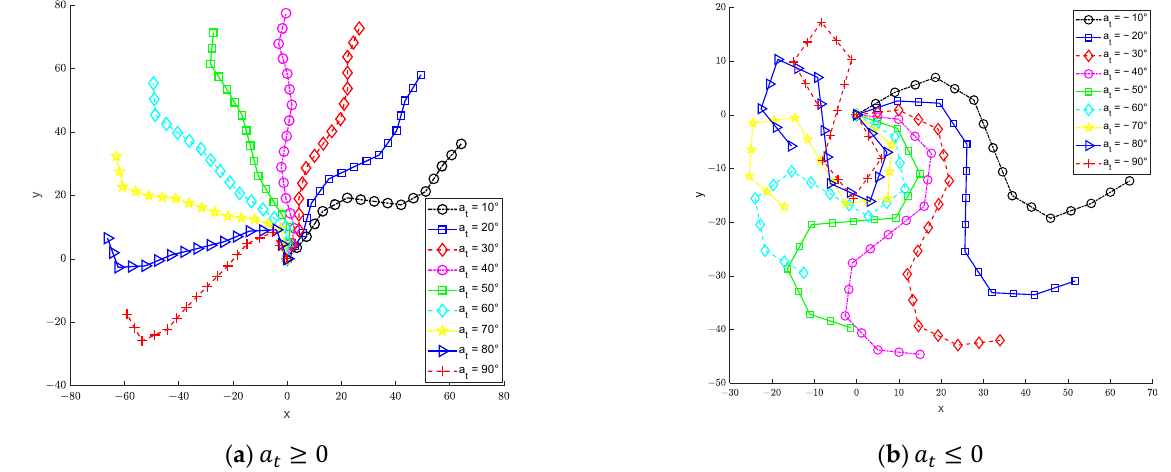
Figure 6. The influence of control parameter 𝑎 (cid:3047) on the movement of snake robot.